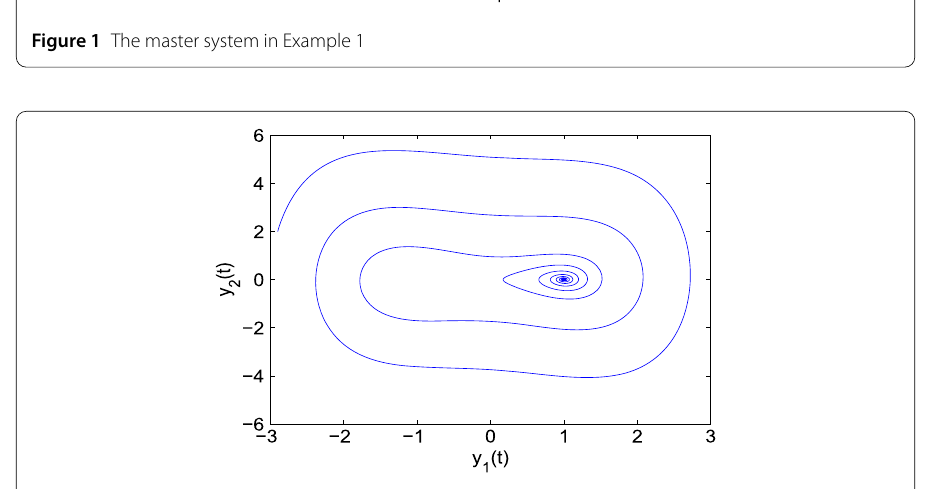
Figure 2 The slave system in Example